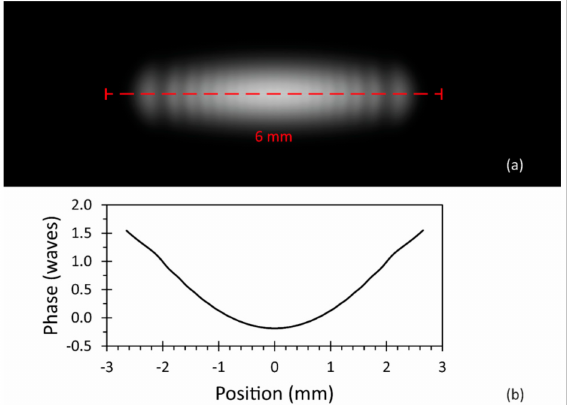
Figure 9. Simulated laser beam characteristics after 600 mm of free space propagation: ( a ) simulated irradiance, normalized to an image gray value of 200 for peak irradiance in the center; ( b ) simulated unwrapped phase profile along the fast beam